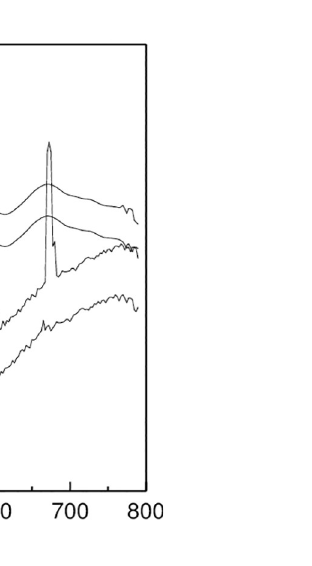
Fig 1. DSC patterns of the deposits Ni-Mo alloy at different heating